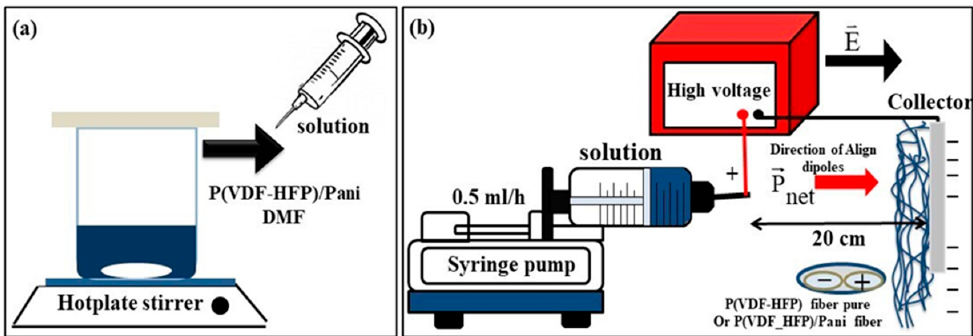
Figure 1. Schematic drawing of ( a ) preparation of homogeneous solution and ( b ) electrospinning setup.